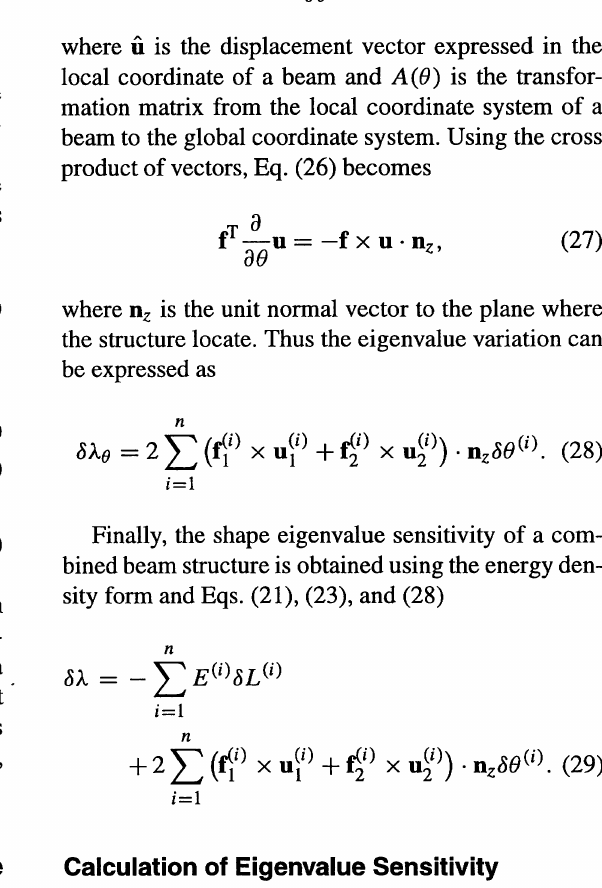
FIGURE 5 Shape variation of a single beam with a con cept of two beam